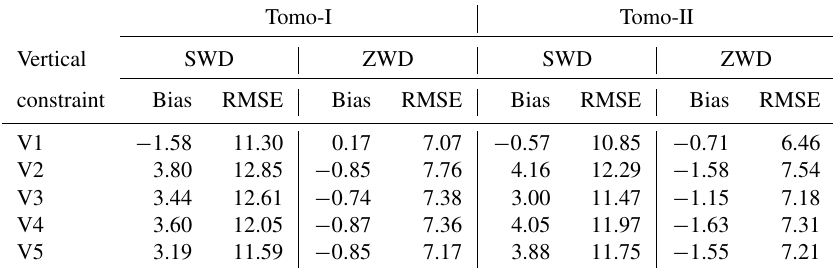
Table 1. Statistics of the differences between GPS-inferred SWD/ZWD and tomography-derived SWD/ZWD over the HKLT station (unit: mm). Tomo-I